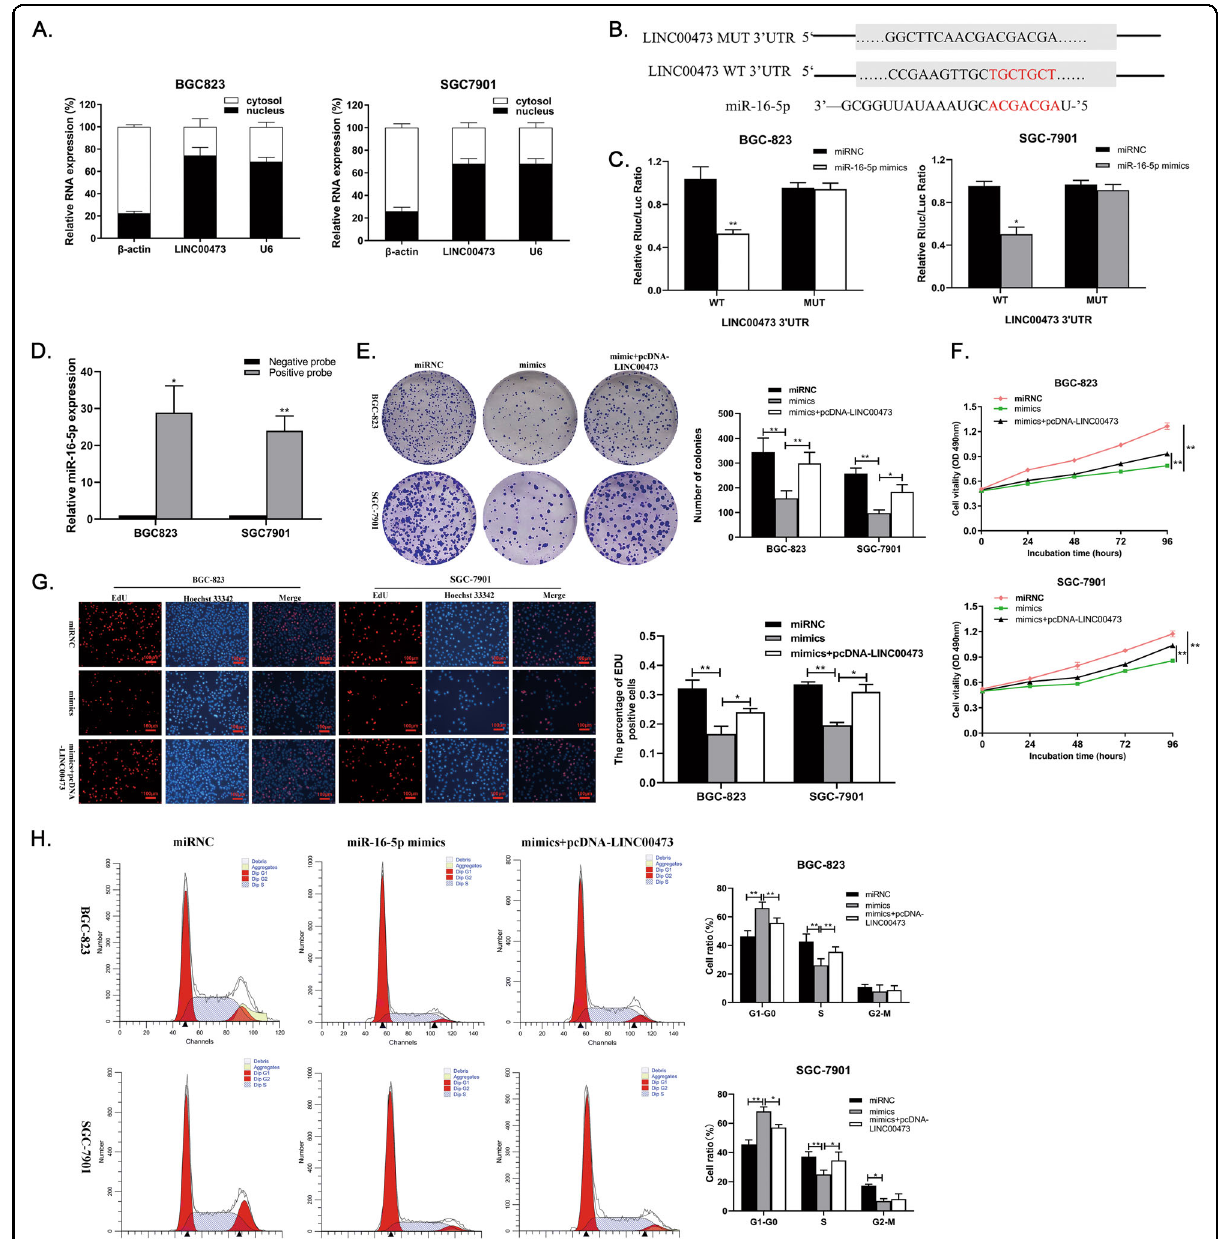
Fig. 5 LINC00473 acts as a sponge for miR-16-5p in the cytoplasm. A Relative LINC00473 expression levels in nucleus and cytoplasm of BGC823 and SGC7901 cells. Nuclear controls: U6; Cytosolic controls: β -actin. B The predicted binding locus between LINC00473 and miR-16-5p. C Luciferase activity in BGC823 and SGC7901 cells were co-transfected with miR-16-5p and luciferase reporters containing LINC00473 or mutant transcript. Data are presented as the relative ratio of Renal luciferase activity to fi re fl y luciferase activity. D The lysates of BGC823 and SGC7901 cells were incubated with a biotin-coupled positive or negative LINC00473 probe. After pull-down, miR-16-5p was extracted and detected by qRT-PCR. E – G Colony- formation, CCK-8, and EdU immunostaining assays were used to determine the proliferation for miR-16-5p mimic and pcDNA-LINC00473 co- transfected BGC823 and SGC7901 cells. Original magni fi cation, ×100. Scale bar: 100 µm. H Flow cytometry was employed to examine the alteration of BGC823 and SGC7901 cells cycle co-transfected with miR-16-5p mimic and pcDNA-LINC00473. Values are shown as the mean ± SD based on three independent experiments. * P < 0.05, ** P <